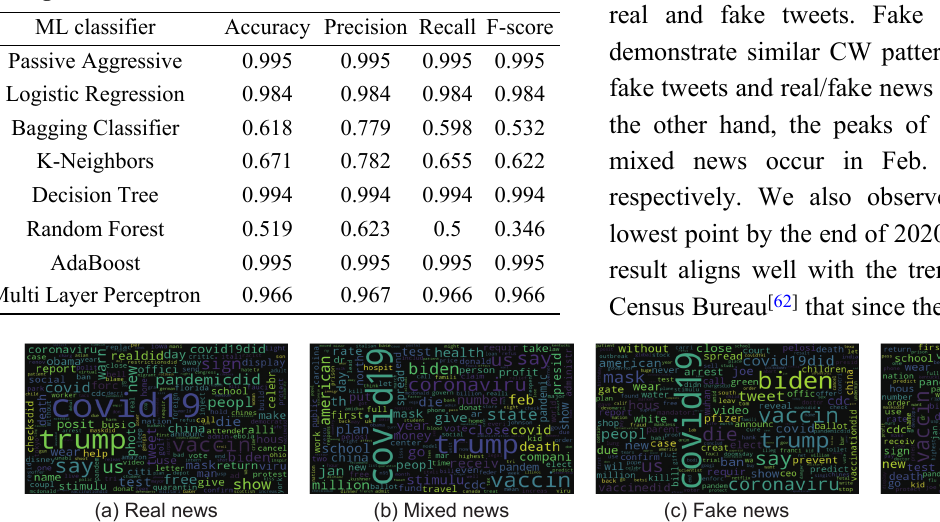
Table 4 Prediction performance of various machine learning classifiers.